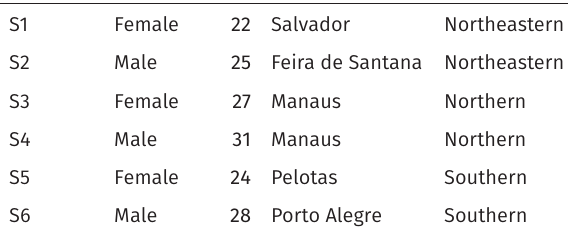
Table 3: Overview of the details of the